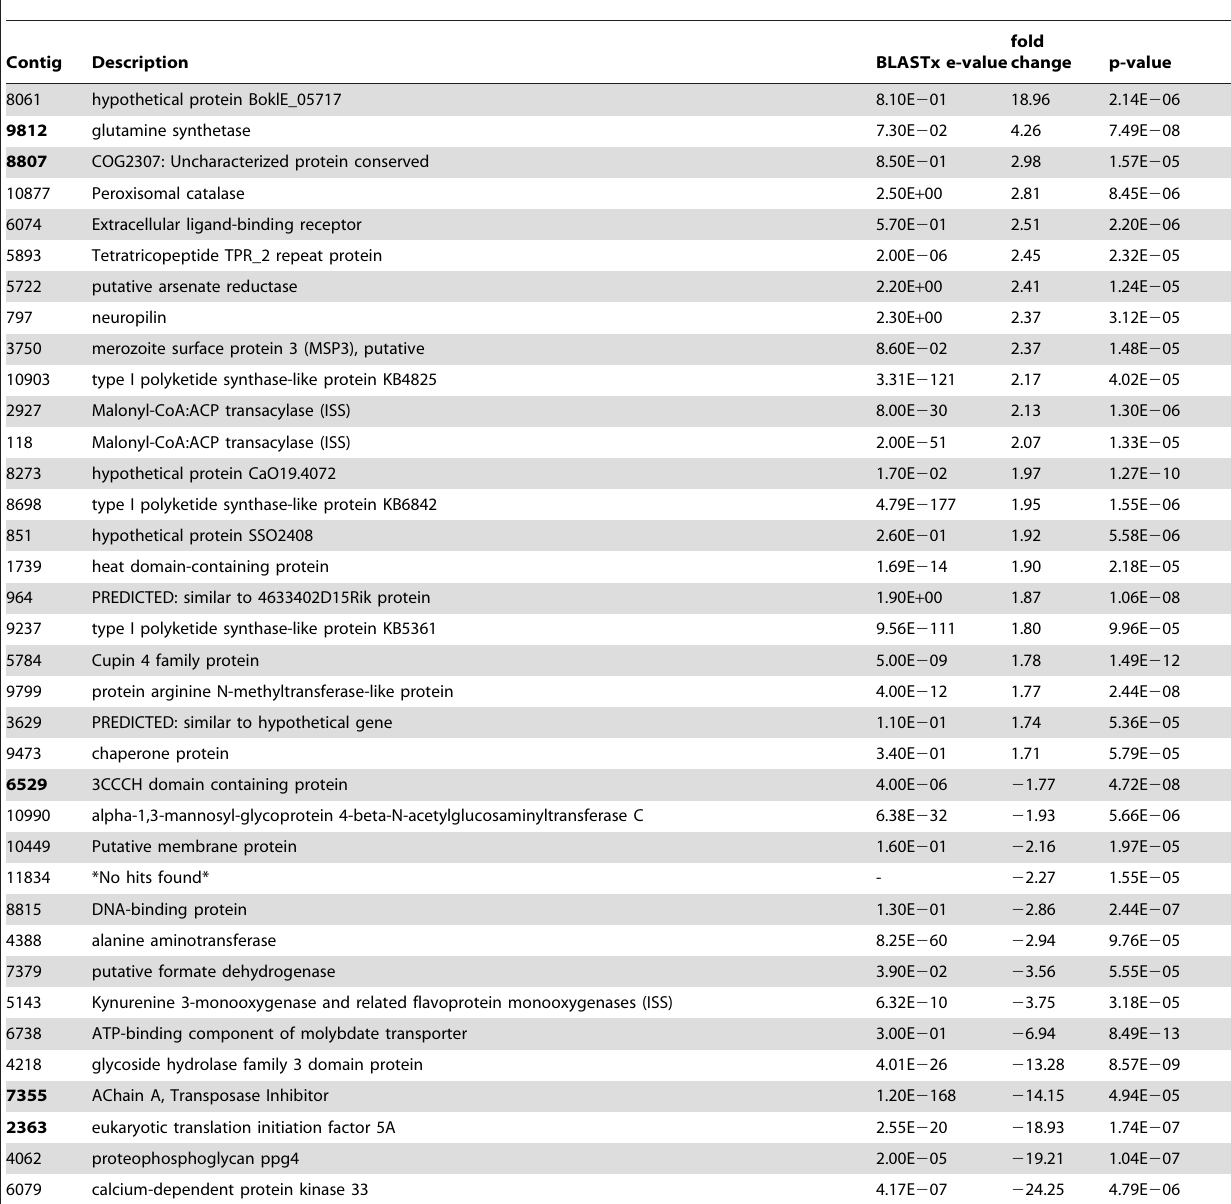
Table 3. Array features with significantly different abundance during the fourth hour post-nitrate addition, relative to N-depleted